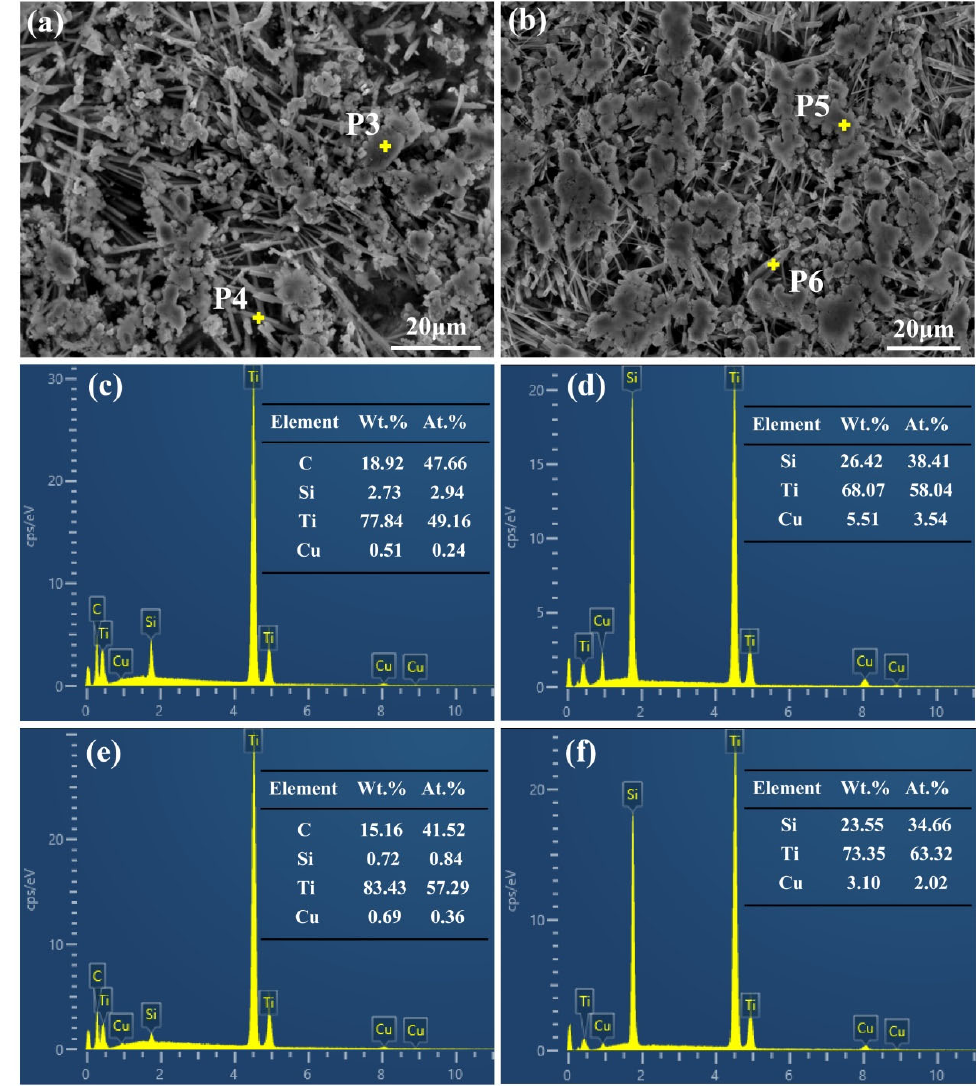
Figure 6. Microstructures and EDS point analysis of deeply etching samples. ( a ) Microstructures of Cu ‐ 6.8Ti ‐ 1.4Si ‐ 0.6C; ( b ) microstructures of Cu ‐ 9.72Ti ‐ 2Si ‐ 0.86C; ( c – f ) EDS point analysis result of P3, P4, P5 and P6, respectively (P3,P5 ‐ TiC; P4,P6 ‐ Ti 5 Si 3 ).